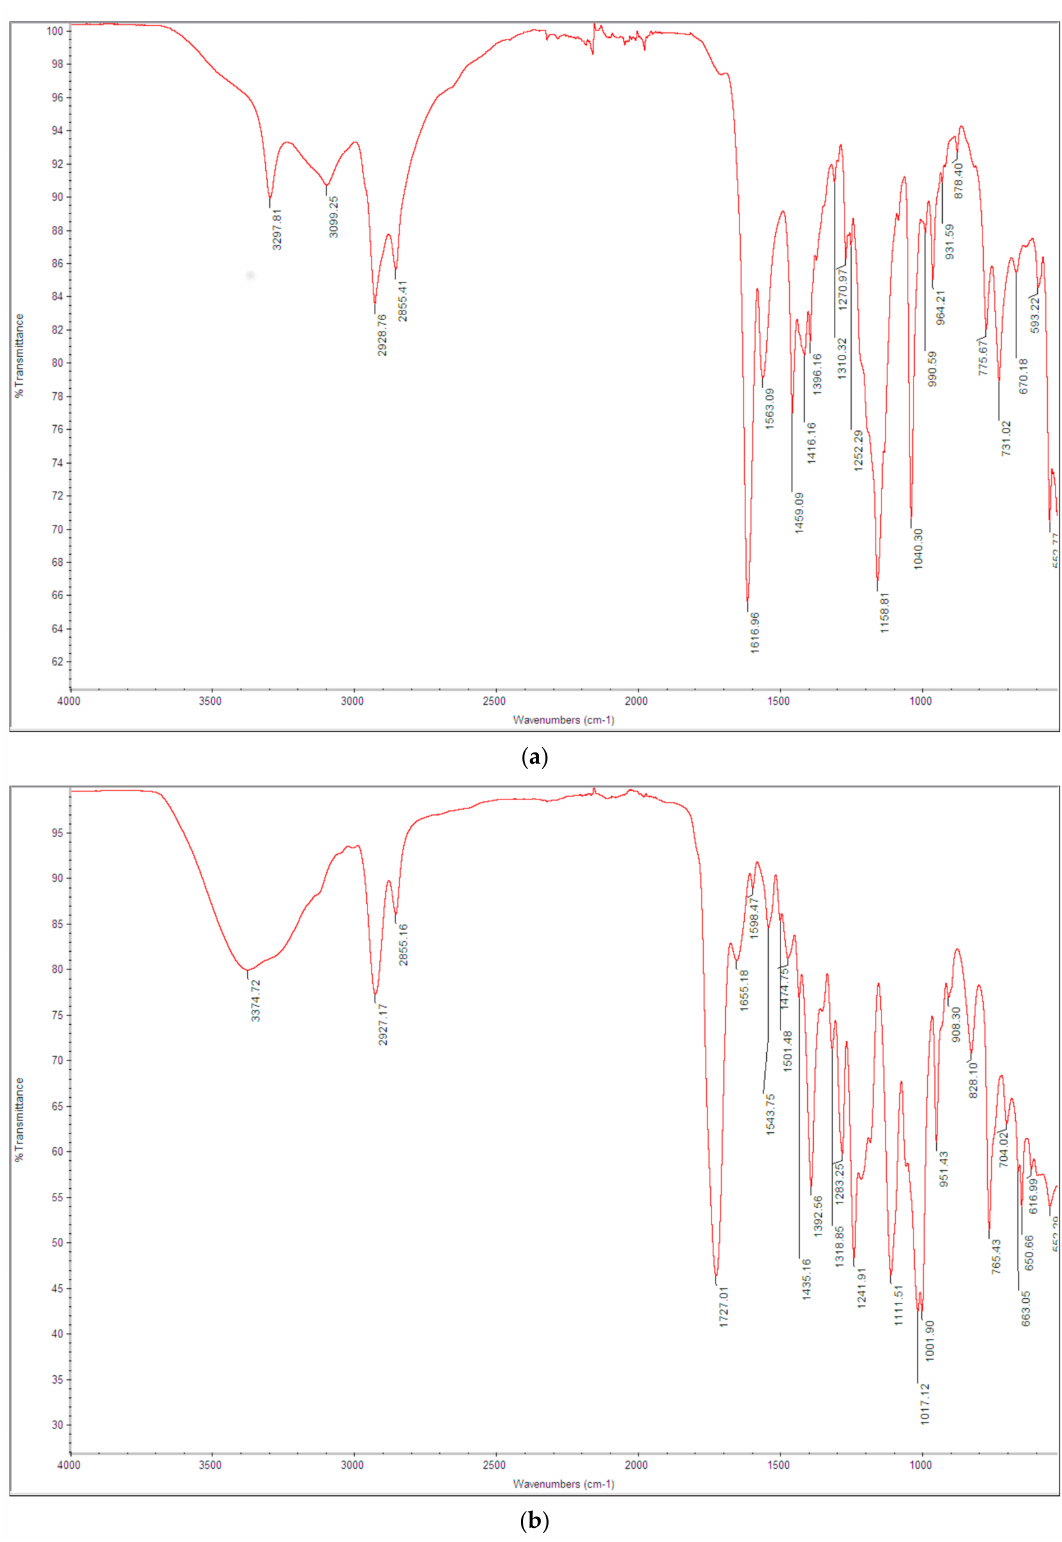
Figure 3. FTIR spectra in the solid phase of ( a ) DFO@EVOH and ( b )